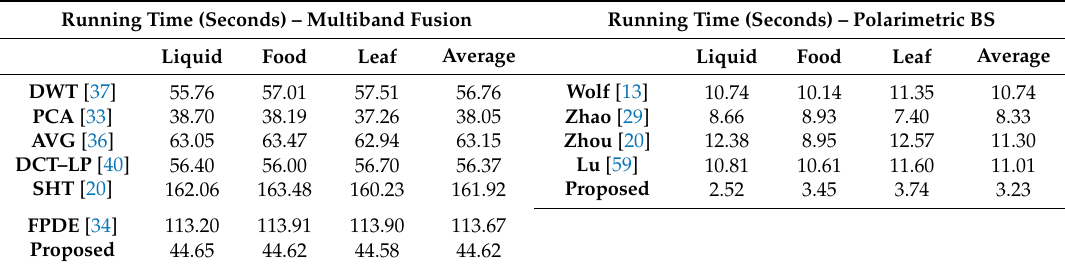
Table 4. Analysis of computational times of different techniques for three scenes in the MSPI dataset. Running Time (seconds) – Multiband Fusion